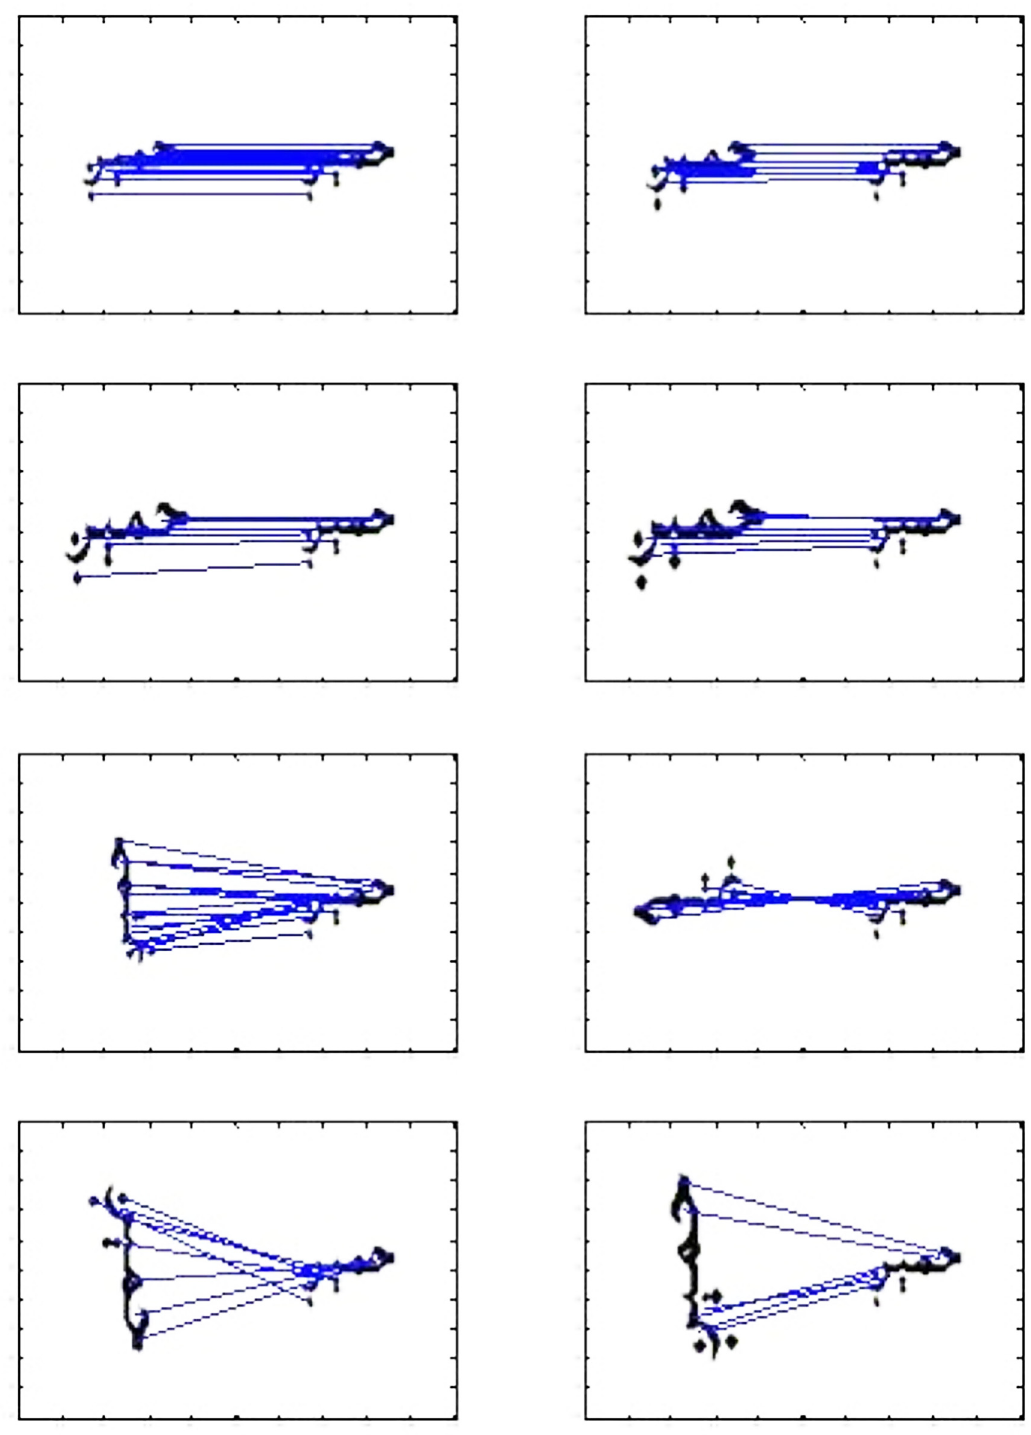
Fig 5. Illustration of Ligature matching with all available ligatures against SIFT-S1 descriptor.